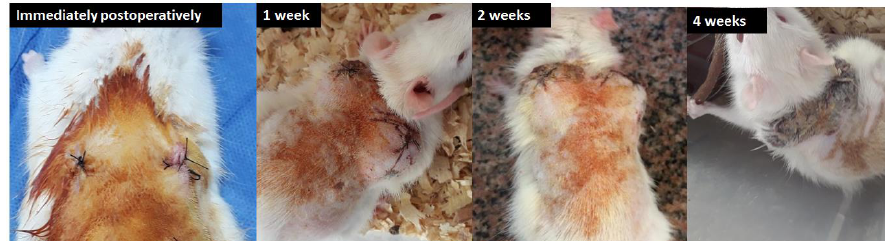
Figure 11. Gross clinical observations immediately postoperatively, and after intervals of one, two and four weeks.